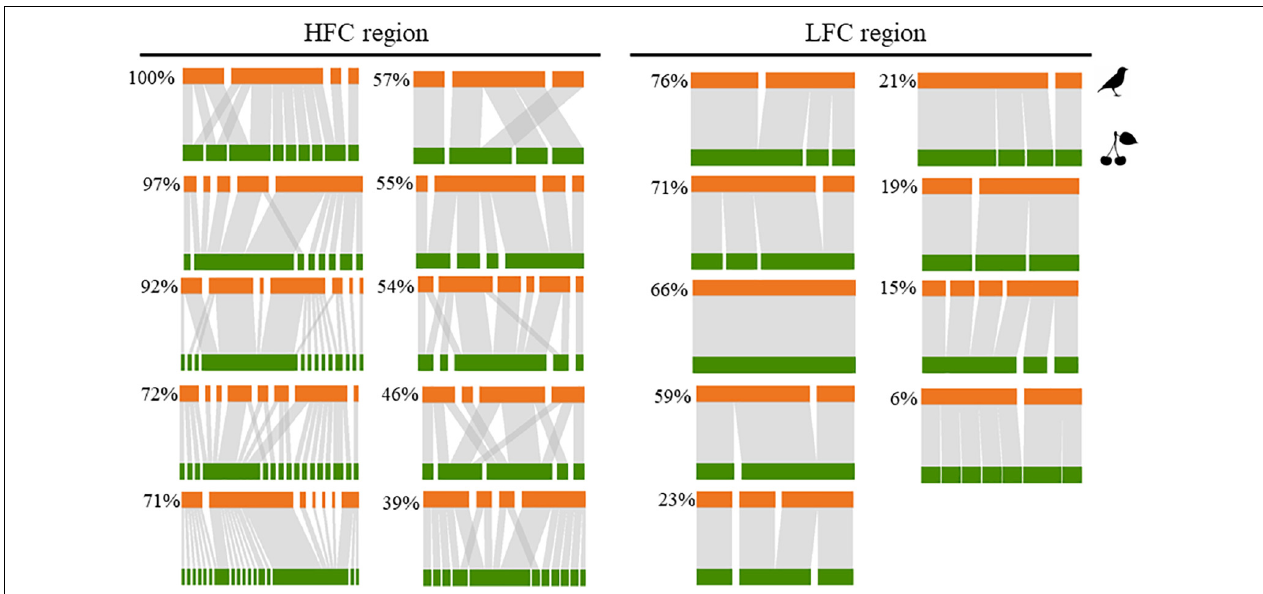
FIGURE 2 | Bipartite seed-dispersal networks in 19 forest sites located in the Brazilian Atlantic forest. At the left, networks observed in the high forest cover (HFC) and at the right, networks observed in the low forest cover (LFC) region, and their respective values of forest cover (%). Orange bars represent bird species and green bars represent the plant species; the frequency of seed-dispersal interactions among bird and plant species are represented by the width of the vertical bars.